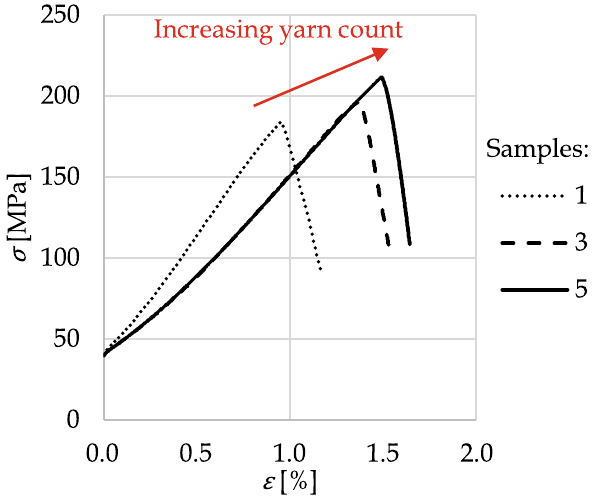
Fig. 14 Stress–strain master curves of yarn samples 1, 3 and 5